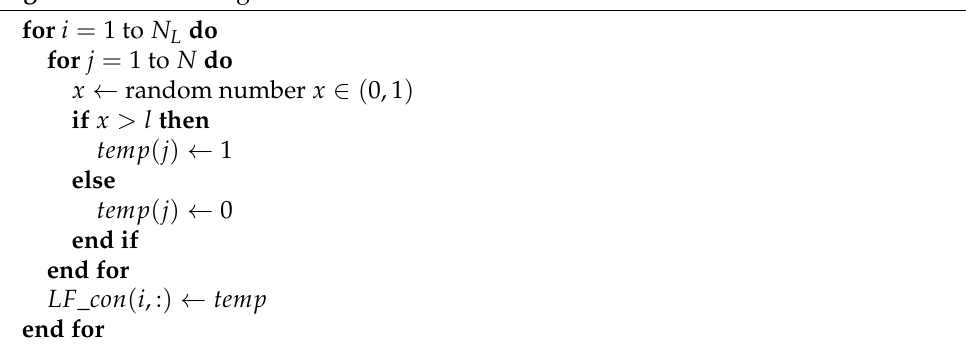
Algorithm 3 Switching leader–follower connection.